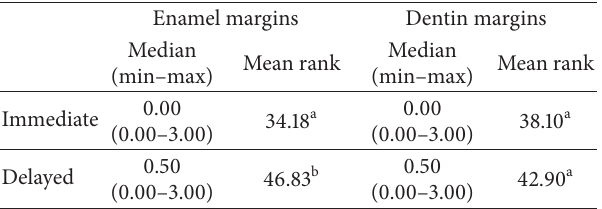
Table 4: Comparison of medians (minimum–maximum) and mean ranks of microleakage according to application time, in enamel and dentin